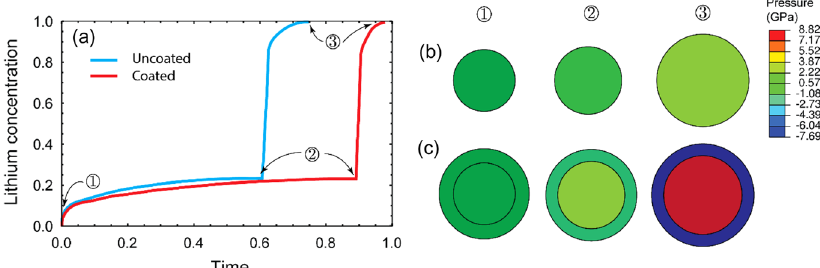
Fig. 8 The Li concentration at the lithiation front indicates different lithiation retardation in uncoated and coated SnNPs. Sn (Tin) features a two-step lithiation mechanism. The fi rst step proceeds by two-phase lithiation with a sharp interface with a product of a -LiSn. The second step proceeds by single-phase lithiation. a The lithiation front tracked by the lithiation concentration with time. Coated SnNP features a stronger retardation than uncoated SnNP. The different lithiation retardation behavior corresponds to the stress generation at different lithiation stages (indicated in ( a )) for the uncoated ( b ) and coated ( c ) SnNPs